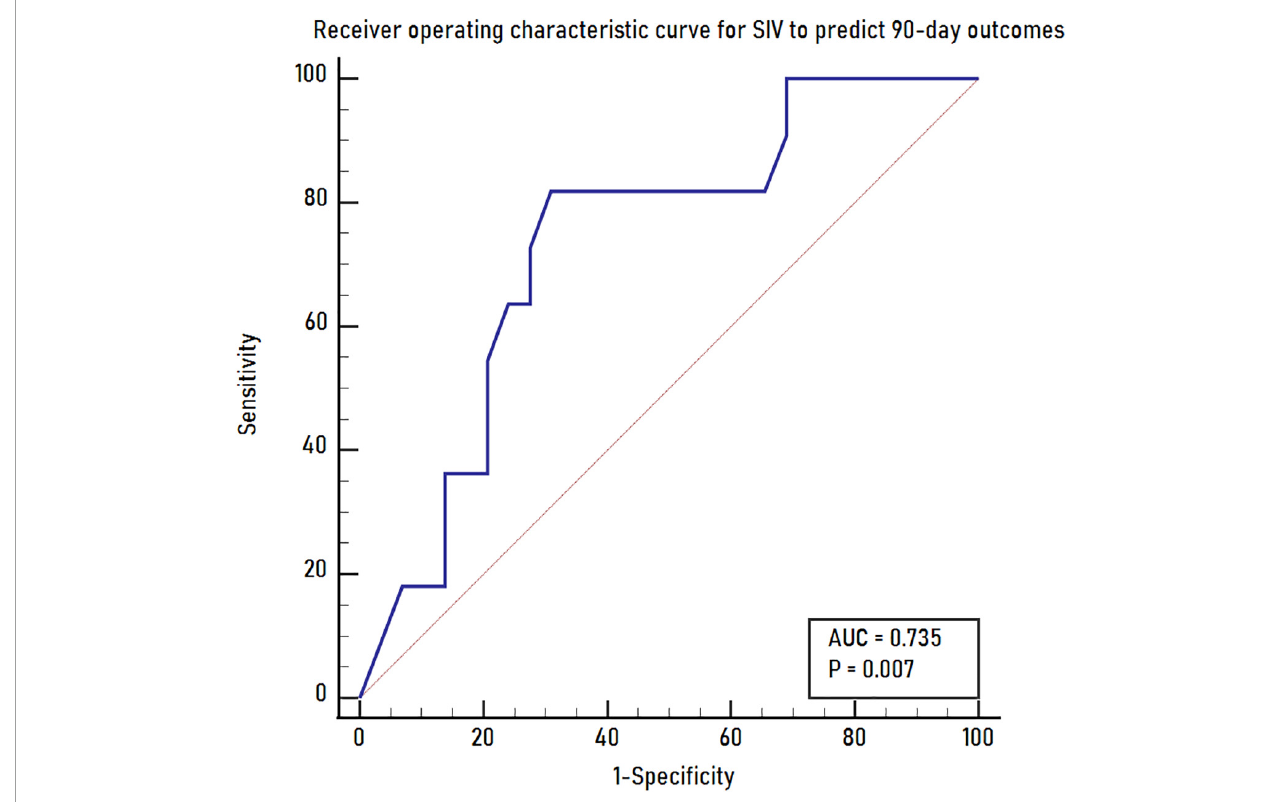
FIGURE3 The receiver operating characteristics curve for SIV to predict 90-day outcomes. SIV, subcortical ischemic